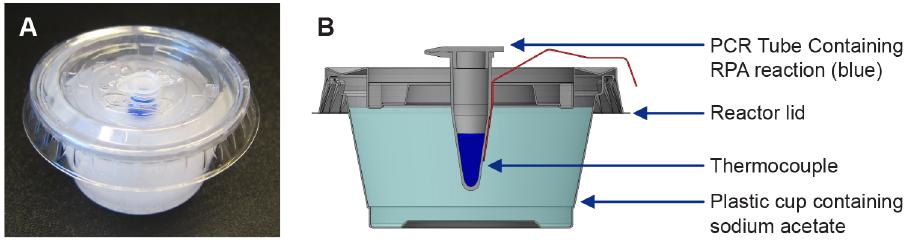
Figure 1. The prototype SAT heater used to incubate RPA reactions. (A) A photograph of an activated SAT heater, the reaction tube is filled with blue dye to improve definition. (B). A cross sectional diagram depicting the SAT heater and other test